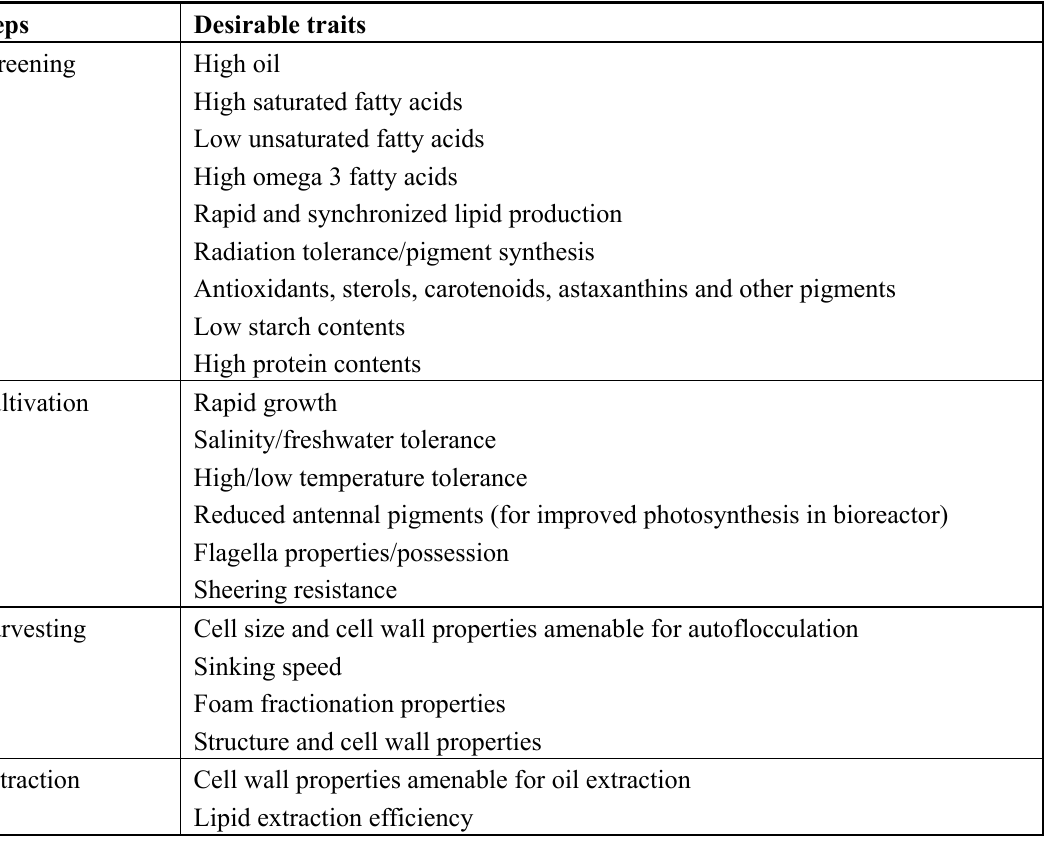
Table 2. Checklist for desirable traits for microalgae selection with potential for biodiesel production and high-value